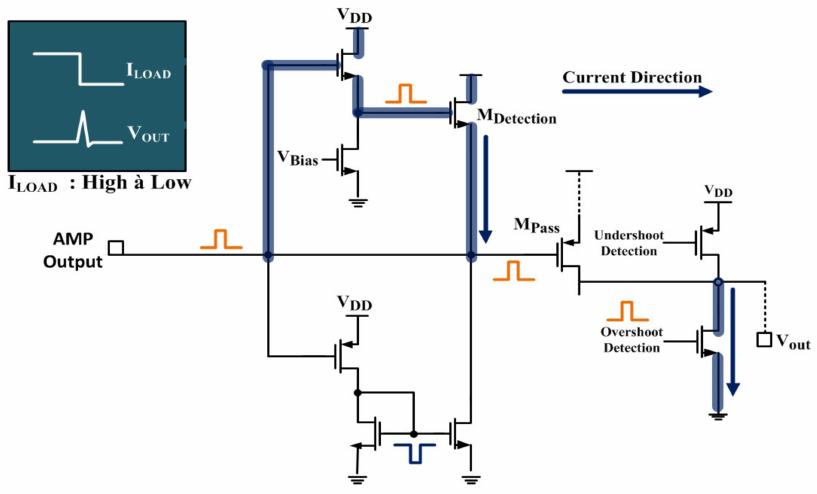
Figure 4. Current Driving Buffer Structure with overshoot in the proposed LDO